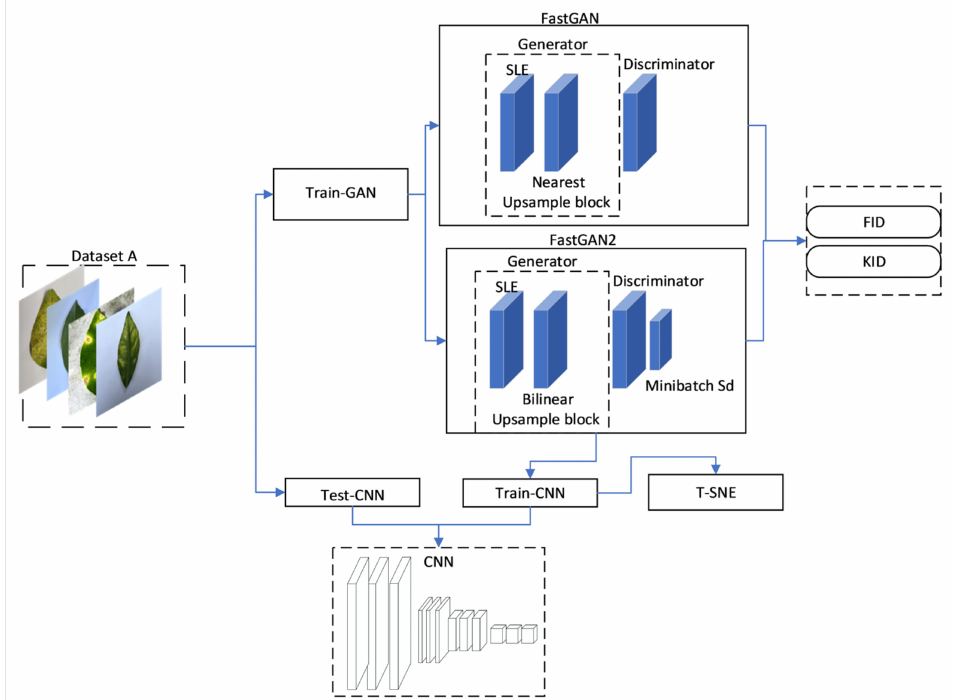
Figure 2. Framework flowchart of generation and classification. Dataset A is divided into Train-GAN and Test-CNN. Train-GAN is used to train FastGAN and FastGAN2. The trained FastGAN2 generates Train-CNN as the training set of CNN and Test-CNN as the tFest set. T-SNE is used to evaluate the quality of Train-CNN. FIID and KID are used to compare the ability of FastGAN and FastGAN2 to generate